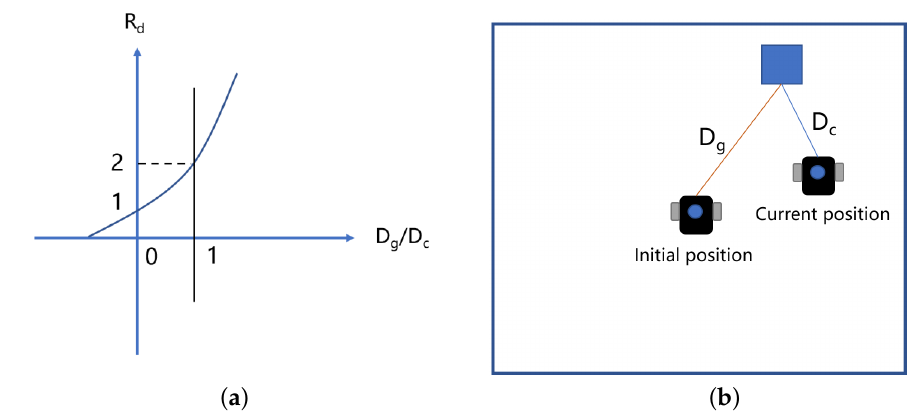
Figure 5. ( a ) Describes absolute distance as a function of current distance ratio and R d reward. ( b ) Explains absolute and relative